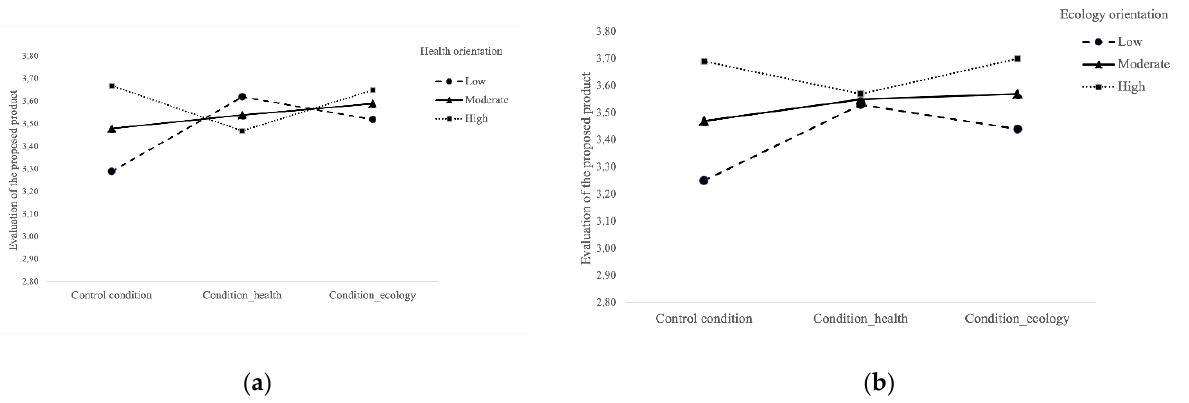
Figure 1. Interaction effect of the experimental condition and of ( a ) health orientation, and ( b ) ecological orientation (Polish consumers sample).